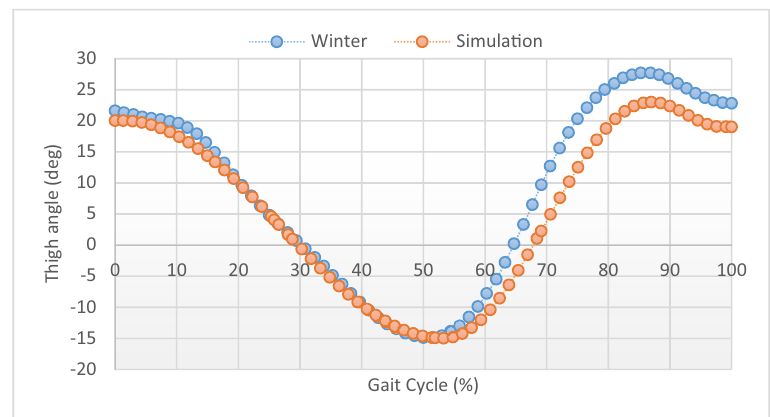
Figure 15: Comparison between model and healthy leg: thigh angle vs gait cycle.